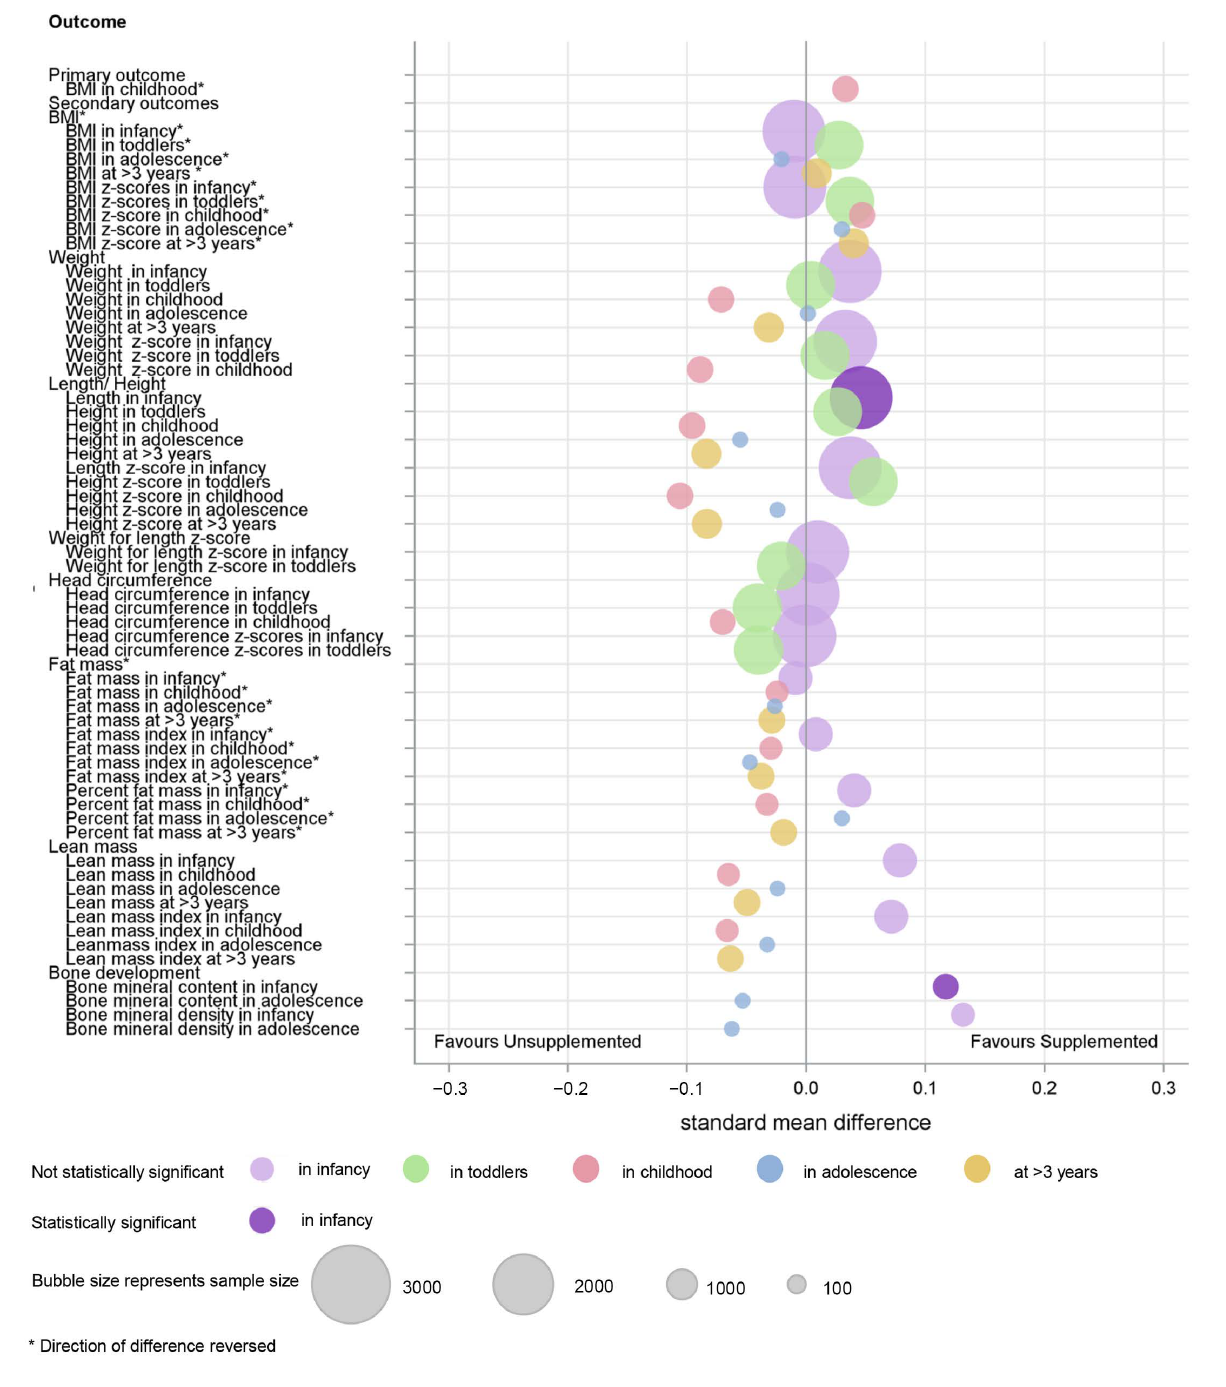
Figure 3. Summary of IPD analysis of macronutrient supplements on growth